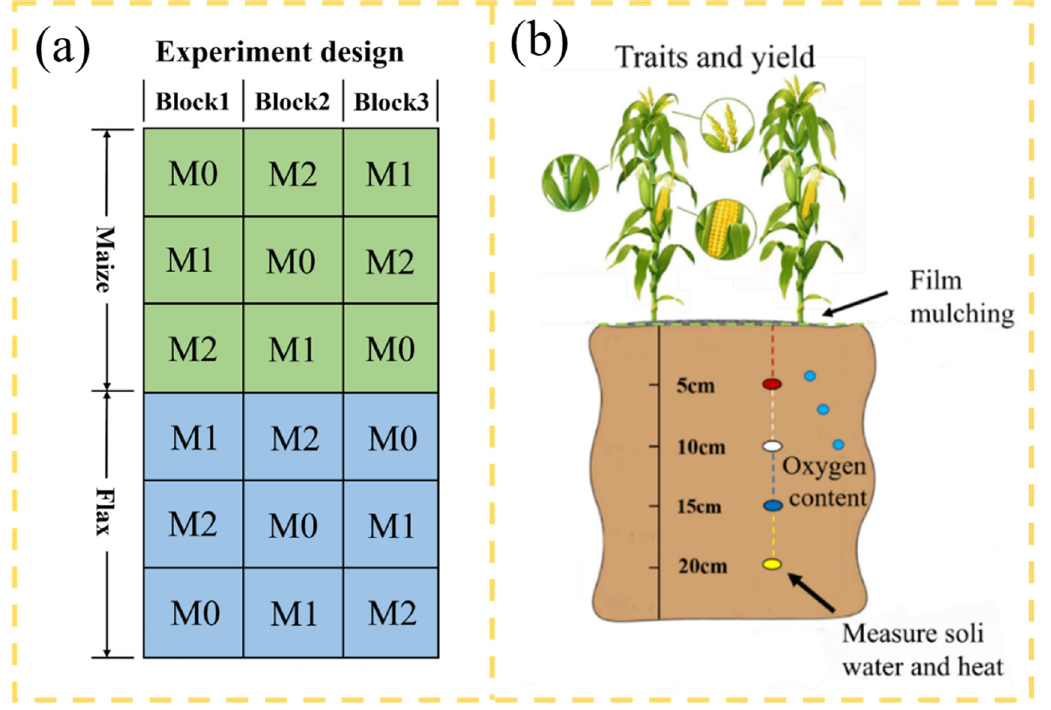
Figure 3. ( a ) Design drawing of test area group. ( b ) Sampling schematic diagram of temperature, moisture content, and oxygen content.